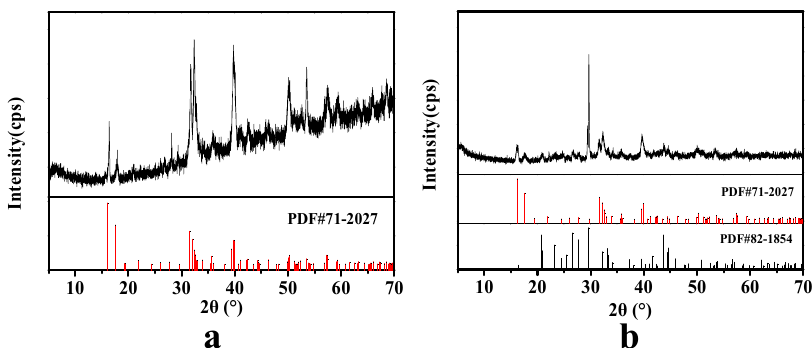
Figure 4. ( a ) XRD patterns for the green pigment (atacamite; Cu(OH) 3 Cl) in M1 sample; ( b ) XRD patterns for the green pigment(atacamite and anglesite; Cu(OH) 3 Cl and PbSO 4 ) in X3 sample.